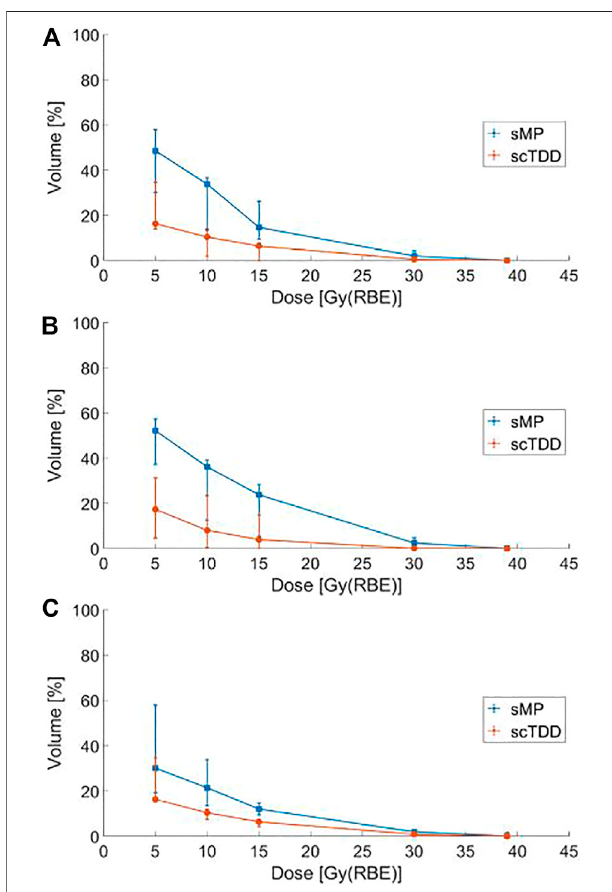
FIGURE 4 | Median dose-volume histogram (DVH) for the contralateral oral mucosa with the S MP and SC TDD in all patients (A) , patients with oral cavity cancer (B) , and patients with tonsil cancer (C) . The bars represent the fi rst (25%) and third (75%) quartiles for each dose.